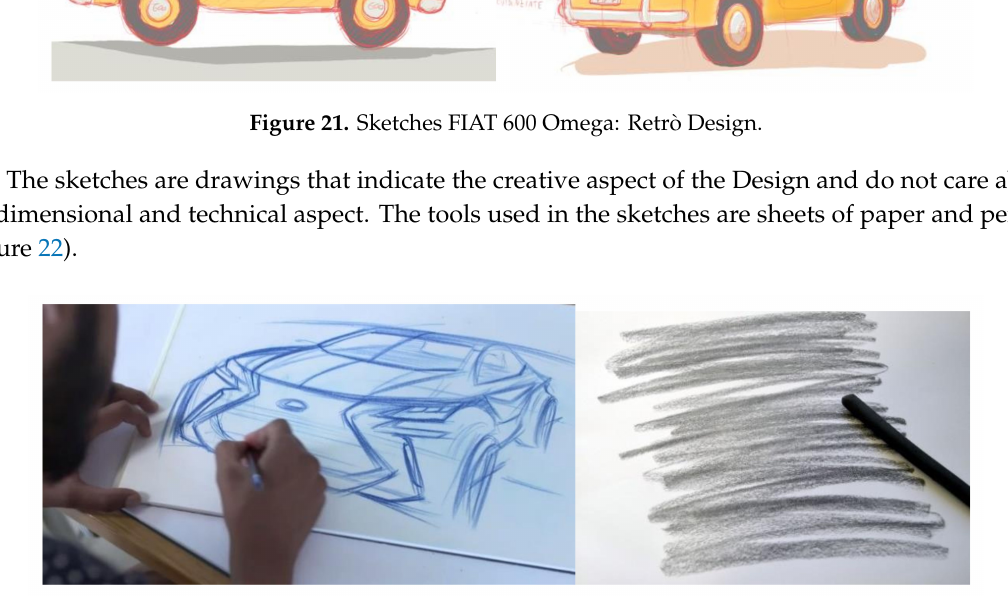
Figure 22. Sketches tools: sheets of paper and